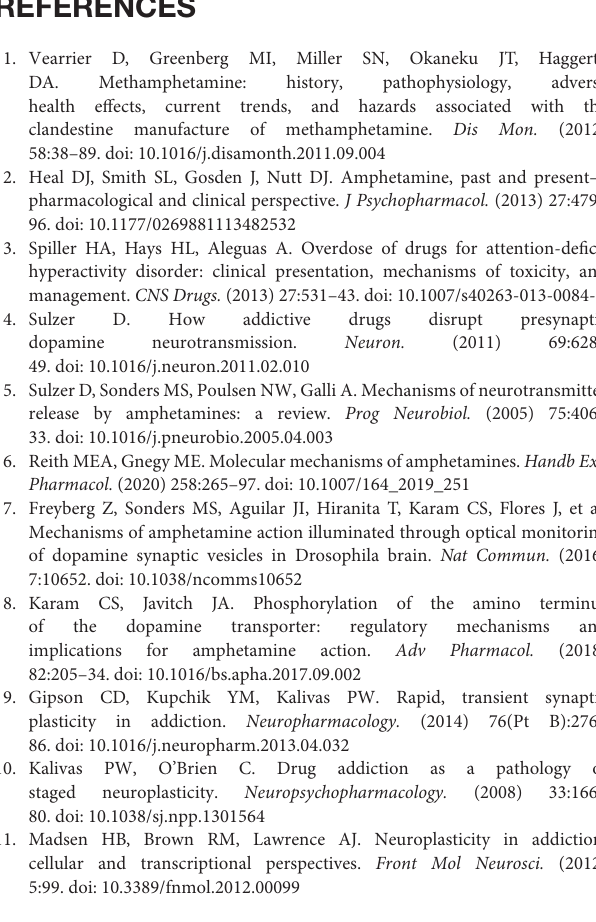
threshold below 0.05 and sorted in increasing order from left to right in the diagrams. Supplementary Figure 2 | RNAi-mediated knockdown of candidate genes was targeted to all neurons using elav-GAL4. Bar graphs depict change in activity in response to 5mM AMPH (blue) or 10mM AMPH (yellow). Error bars indicate SEM. Statistical significance was determined by Kruskal-Wallis ANOVA ( p < 2e-16). Asterisks indicate pairwise significance compared to genotype control after AMPH treatment, as determined by post-hoc Dunn’s Test with a Benjamini-Hochberg correction for multiple testing, ∗∗∗∗ p .adj < 0.0001, ∗∗∗ p .adj < 0.001, ∗∗ p .adj < 0.01, ∗ p .adj < 0.05. Supplementary Table 1 | List of transcripts differentially expressed in response to AMPH in WT and in DAT mutant. Supplementary Table 2 | GO terms and functional enrichment analysis for DAT-independent genes. DATindependent is the list of DE genes common between WT and DAT mutant; up and dn list the FBtr recognized by DAVID for up- and downregulated genes; upANNO and dnANNO contain all significant annotations ( p < 0.1) in all functional databases used in DAVID. Supplementary Table 3 | GO terms and functional enrichment analysis for DAT-dependent genes. DATdependent is the list of DE genes unique to WT; up and dn list the FBtr recognized by DAVID for up- and downregulated genes; upANNO and dnANNO contain all significant annotations ( p < 0.1) in all functional databases used in DAVID. Several functionally related categories share common genes, e.g., GO: 0006413 ∼ translational initiation; GO: 0001731 ∼ formation